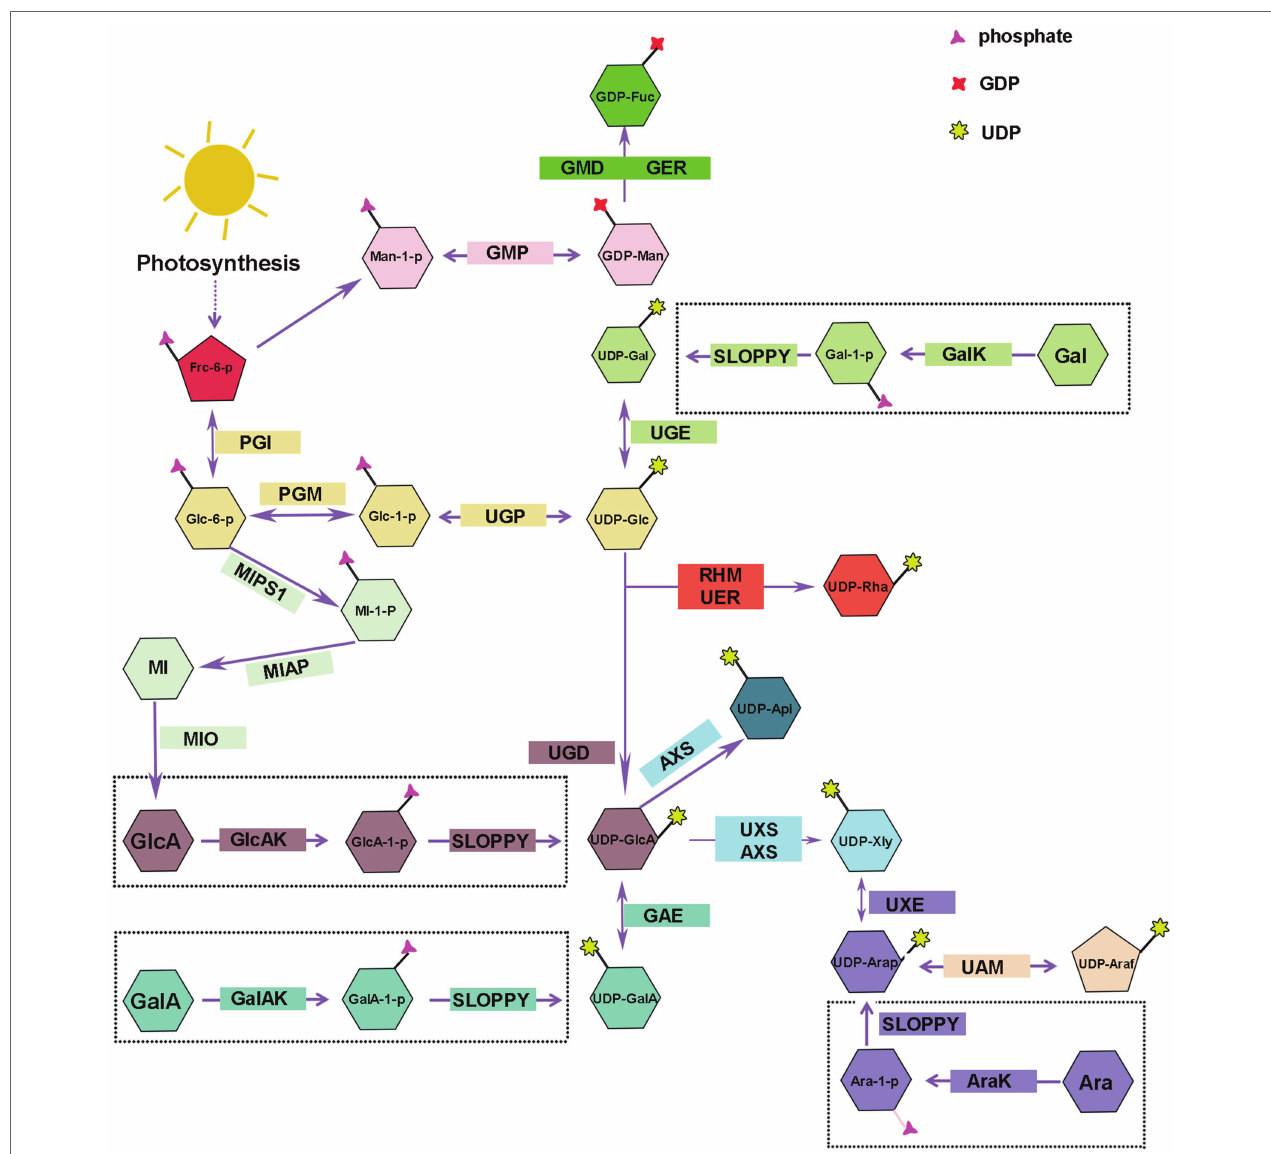
FIGURE 2 | Biosynthesis of nucleotide sugars for plant hemicellulose. Frc-6-P, Fructose-6-phosphate; Glc-1-P, Glucose-1-Phosphate; Man-1-P, Mannose-1- Phosphate; UDP-Glc, uridine diphosphate glucose; UDP-GlcA, UDP-glucuronate; UDP-Api, UDP-Apiose; Xyl, UDP-xylose; UDP-Gal, UDP-galactose; UDP-GalA, UDP-galacturonate; UDP-UDP-Ara, UDP-arabinose; UDP-Rha, UDP-rhamnose; GDP-Man, guanosine diphosphate-mannose; GDP-Fuc, GDP-fucose; UGP, uridine diphosphate glucose pyrophosphorylase; GMP, guanosine diphosphate-mannose pyrophosphorylases; UGE, UDP-galactose/glucose 4-epimerase; GalK, galactokinase; UGD, UDP-D-glucose dehydrogenase; GlcAK, glucuronide kinase; GAE, UDP-GlcA 4-epimerase; GalAK, GalA kinase; UXS, UDP-GlcA decarboxylase; AXS, UDP-D-apiose/UDP-D-xylose synthase; UXE, UDP-Xyl epimerase; UAM, UDP-arabinopyranose mutase; RHM, rhamnose synthase; UER, UDP-4-keto- 6-deoxy-D-glucose 3, 5-epimerase 4-reductase; GMD, GDP-mannose-4, 6-dehydratase; GER, GDP-4-keto-6-deoxymannose-3, 5-epimerase − 4-reductase (GDP-fucose synthetase); MIPS1, myo-inositol-1-phosphatase synthase; MI-1-P, myo-inositol-1-phosphatase; MIAP, myo-inositol alkaline phosphatase; MI, myo-inositol; MIO, myo-inositol